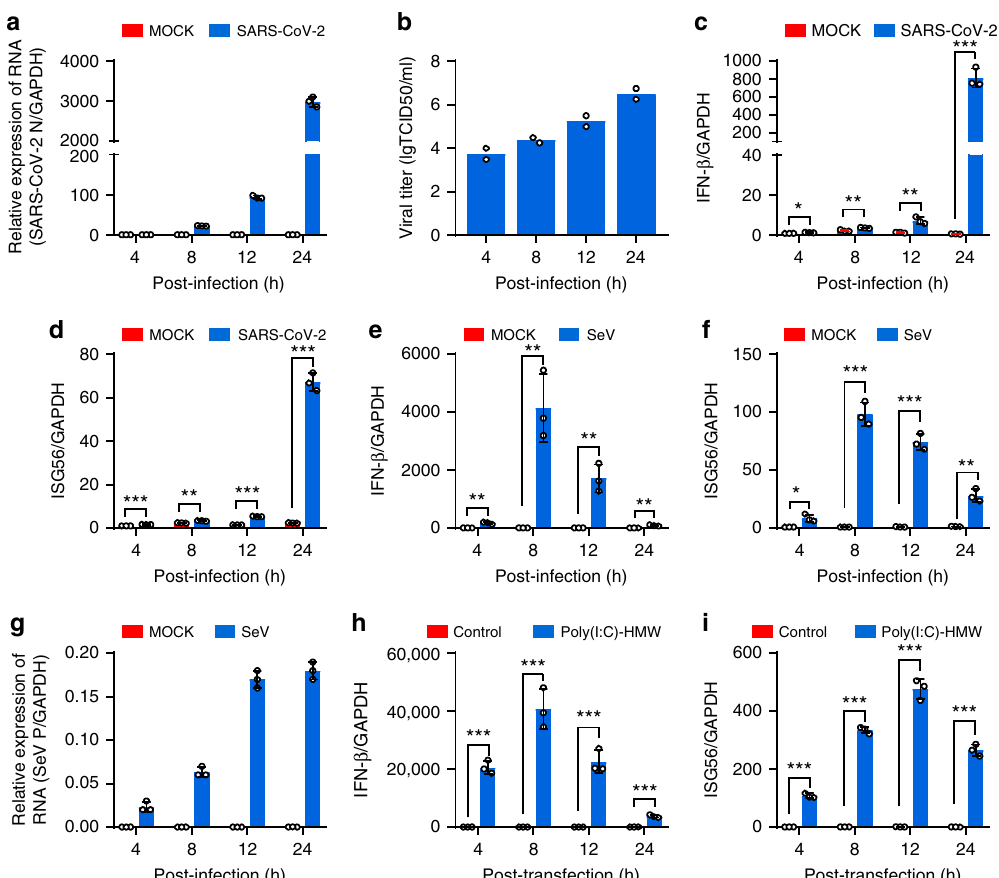
Fig. 1 SARS-CoV-2 infection induces the expression of antiviral genes. a Calu-3 cells were mock-infected or infected with SARS-CoV-2 at an MOI of 0.5. At 4, 8, 12, and 24 h after infection, total RNA extracted from cells was evaluated by quantitative real-time PCR (qRT-PCR) using SYBR green method. The data are expressed as fold changes of the RNA levels of the viral N gene relative to the GAPDH control. b Calu-3 cells were mock-infected or infected with SARS-CoV-2 at an MOI of 0.5. At 4, 8, 12, and 24 h after infection, supernatants were collected, and viral titers were detected by using TCID 50 assay. c , d Cells from a were collected, and total RNA extracted from the cells was evaluated by qRT-PCR using SYBR green method. The data are expressed as fold change of the IFNB mRNA c and ISG56 mRNA d levels relative to the GAPDH control. e – g Calu-3 cells were mock-infected or infected with Sendai virus. Cells were harvested and analyzed as described in c and d . h , i Calu-3 cells were transfected with high molecular weight poly(I:C) (poly(I:C)-HMW). Cells were harvested at indicated times and analyzed by qRT-PCR. All experiments were done at least twice, and one representative is shown. Error bars indicate SD of technical triplicates. * P < 0.05, ** P < 0.01, and *** P < 0.001, two-tailed Student ’ s t -test. Source data are provided as a Source Data fi